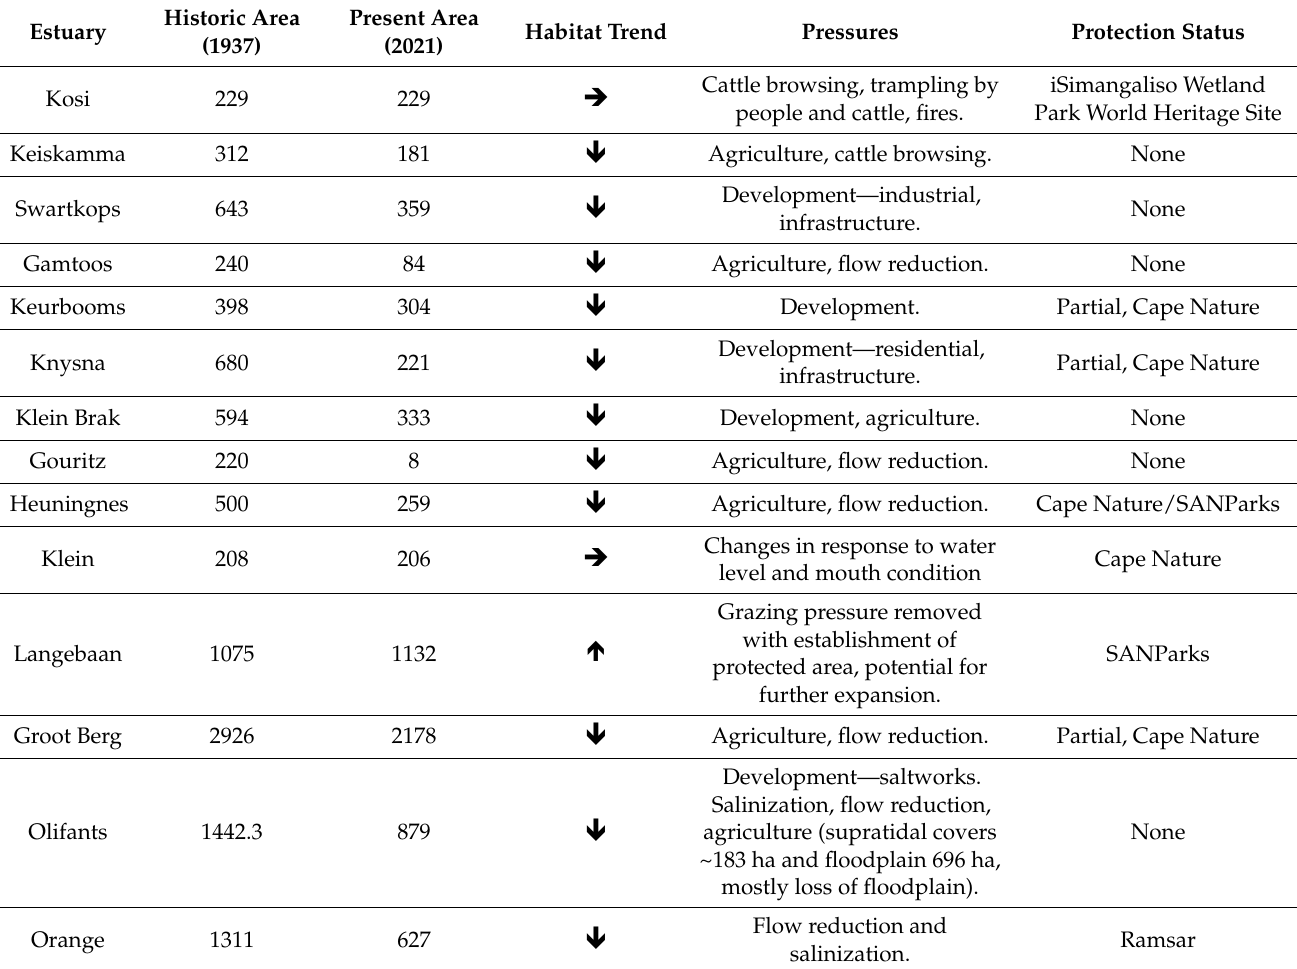
Table 1. Changes in the largest intertidal salt marsh areas (ha) in South Africa (east to west) and the associated pressures and protection status of each estuary. Habitat trends are indicated by arrows ( decreasing, increasing, and stable). Updated from [33] and [54].